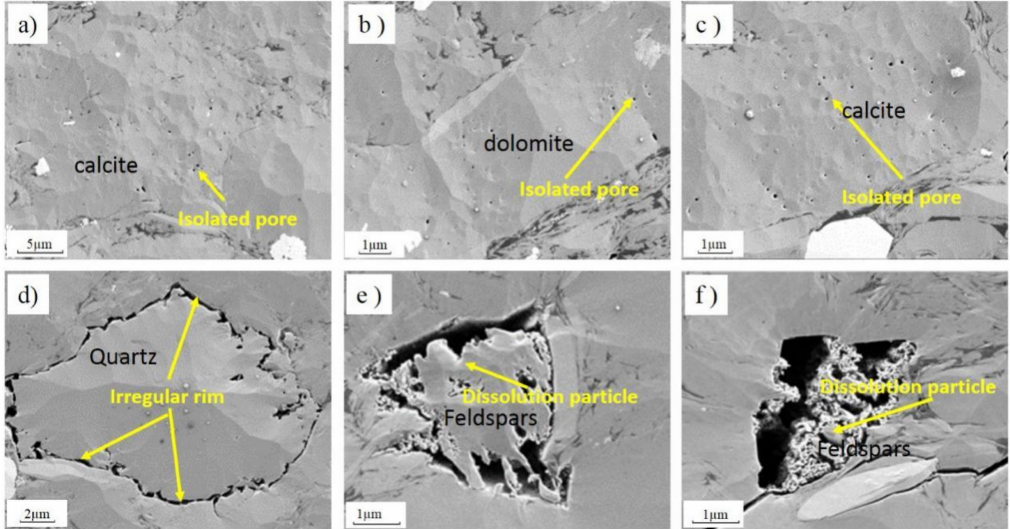
Figure 9. The FIB-SEM 2D images of dissolved pores: ( a – c ) isolated pores of the #1 #3 and #6 samples of the lower Cambrian shale. ( d – f ) Pores with irregular rim and dissolution particle of the #11 #12 and #16 samples of lower Silurian shale.